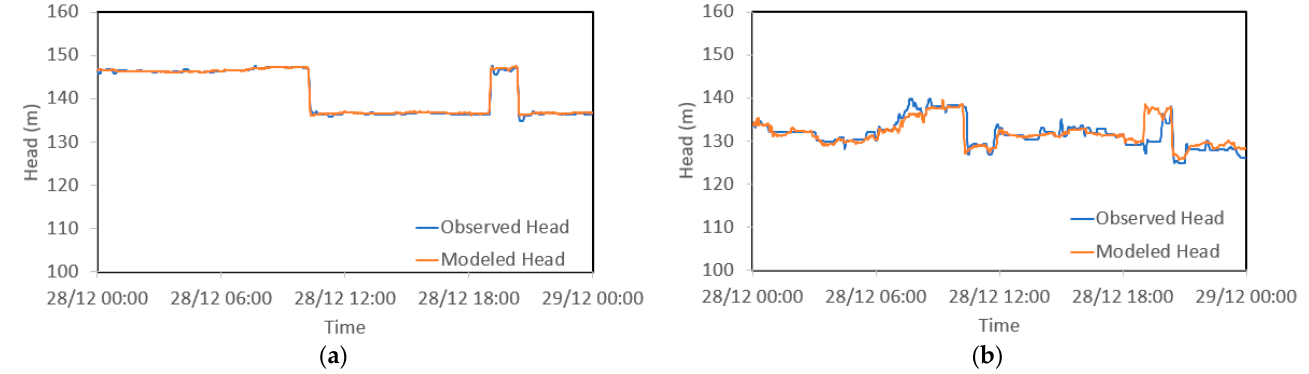
Figure 6. Comparison of the observed and modeled HGL at: ( a ) RTU1; ( b ) RTU5 during the calibration period.